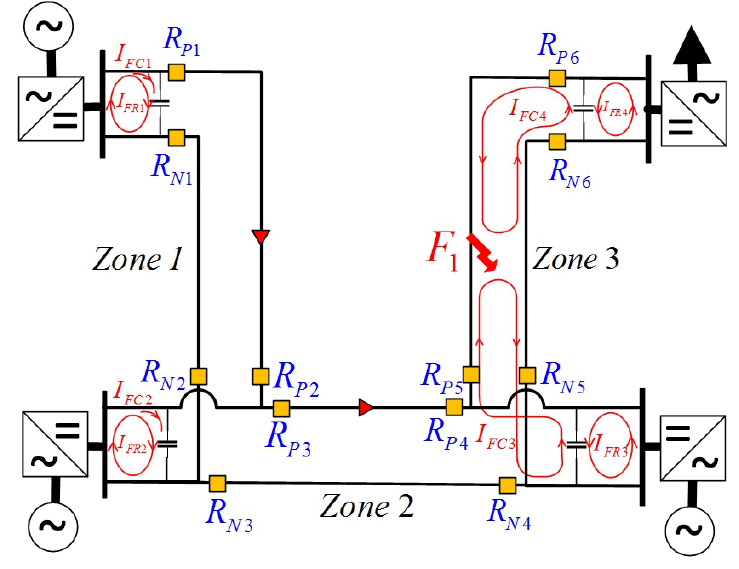
Figure 1. Analyse of FCFH current flow for an external fault in VSC-MTDC